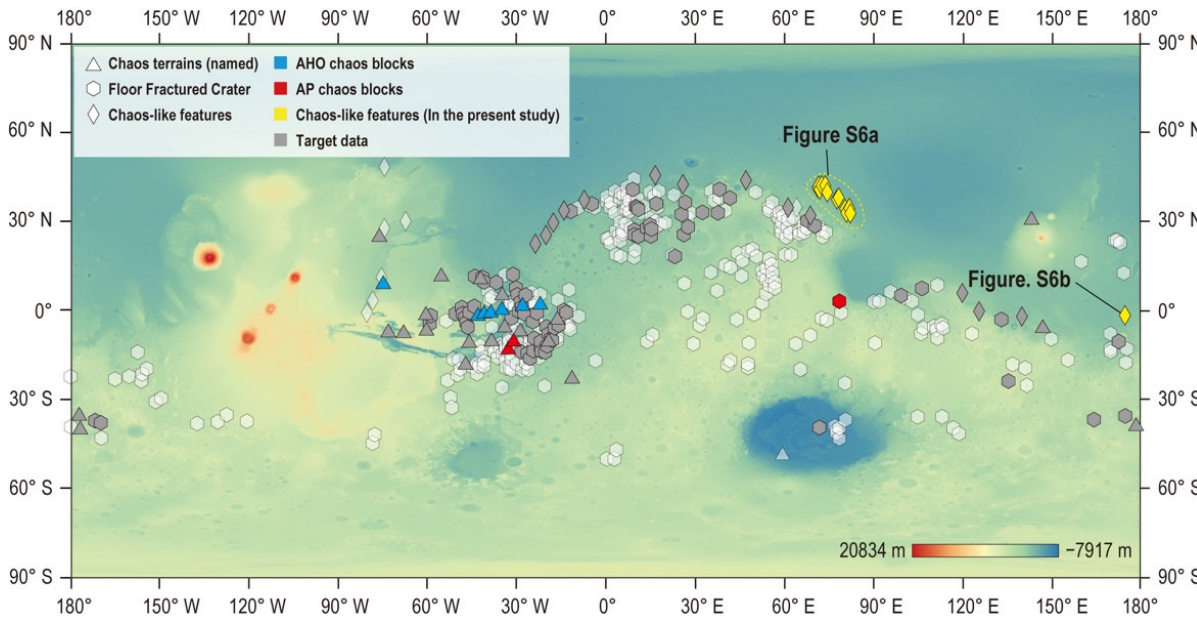
Figure 1. Global distribution of chaotic terrains named by the International Astronomical Union (IAU; triangles: IAU Planetary Names, cf. https://planetarynames.wr.usgs.gov/ (accessed on 14 Jan- uary 2020)), floor-fractured craters (FFCs; hexagons: [14]), and chaos-like features (rhombuses: [15]) on Mars, superimposed on an elevation map. Blue and red colors represent chaotic terrains or FFCs that have been investigated previously based on detailed geological analyses (e.g., [1,2,4–7,16,17]) and which were used as training data for our neural network models in the context of Aromatum- Hydraotes-Oxia-like (or AHO) and Arsinoes-Pyrrhae-like (or AP) chaos blocks, respectively. Yellow circles represent chaos-like features found in the present study (see Figure S6 for the images). Gray color represents the locations of images used as target data.